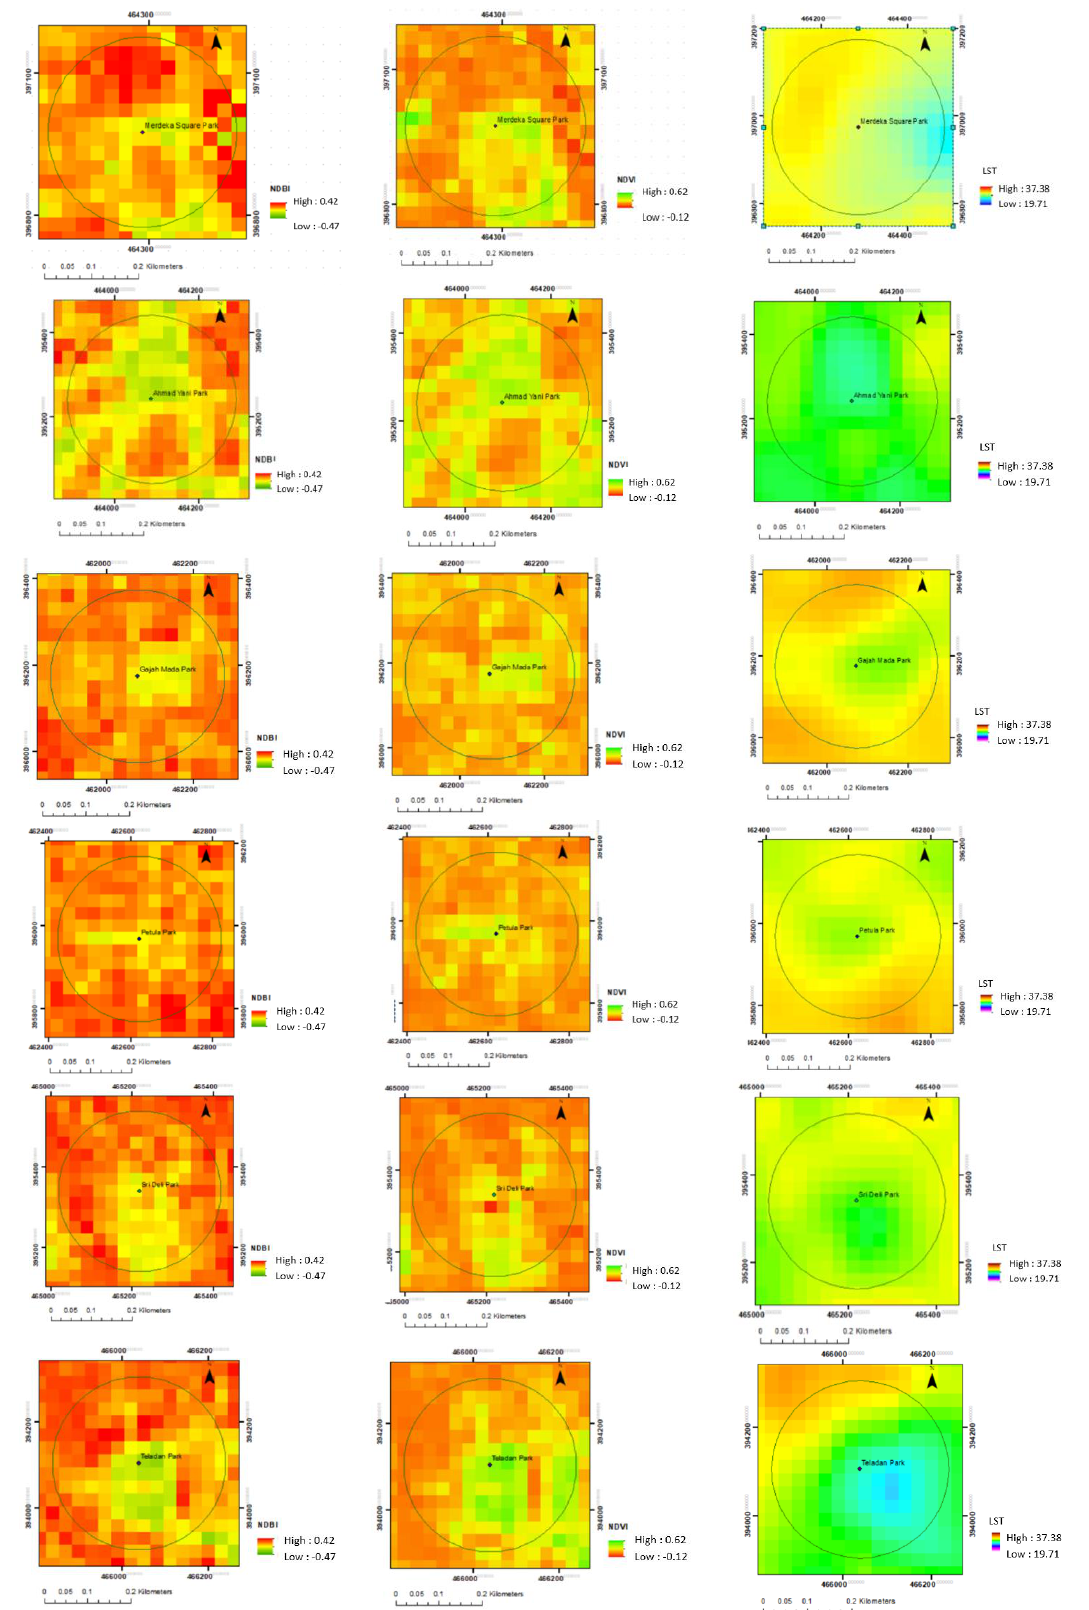
Figure 9. NDBI, NDVI and LST in Each Park in Medan.